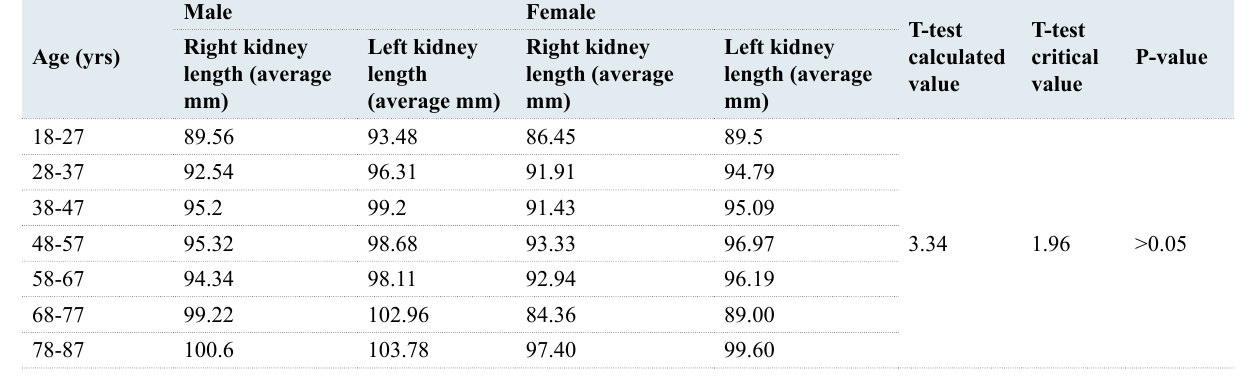
T-test T-test critical calculated value value